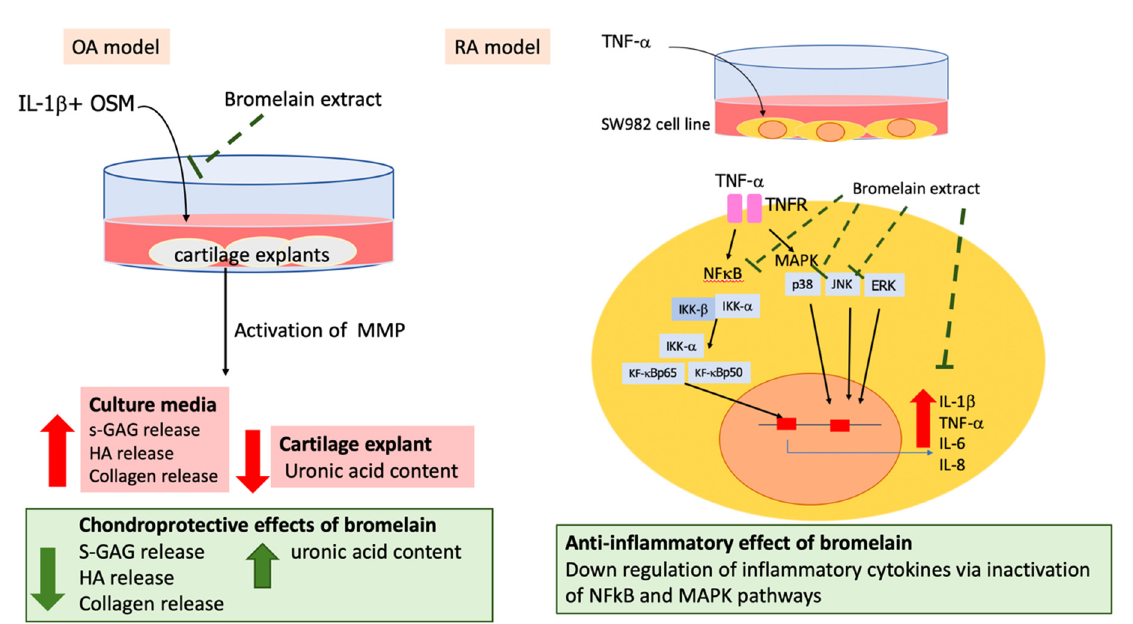
Figure 5. Chondroprotective and anti-inflammatory effects of bromelain extract on IL-1 β –treated porcine cartilage explant (OA model) and TNF ‐α –treated SW982 cells (RA model).